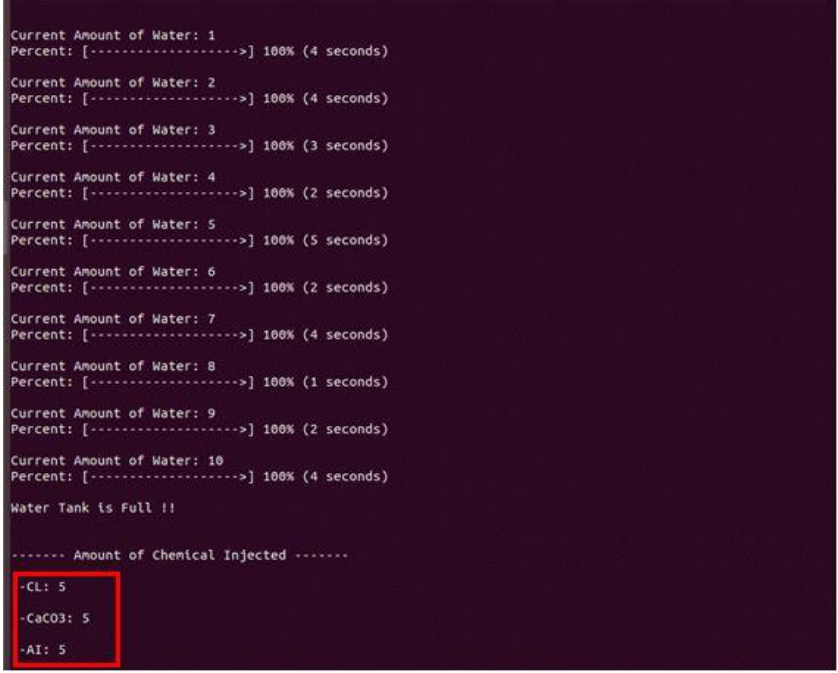
Figure 9. Scenario configuration using Python FreeOpcUa.